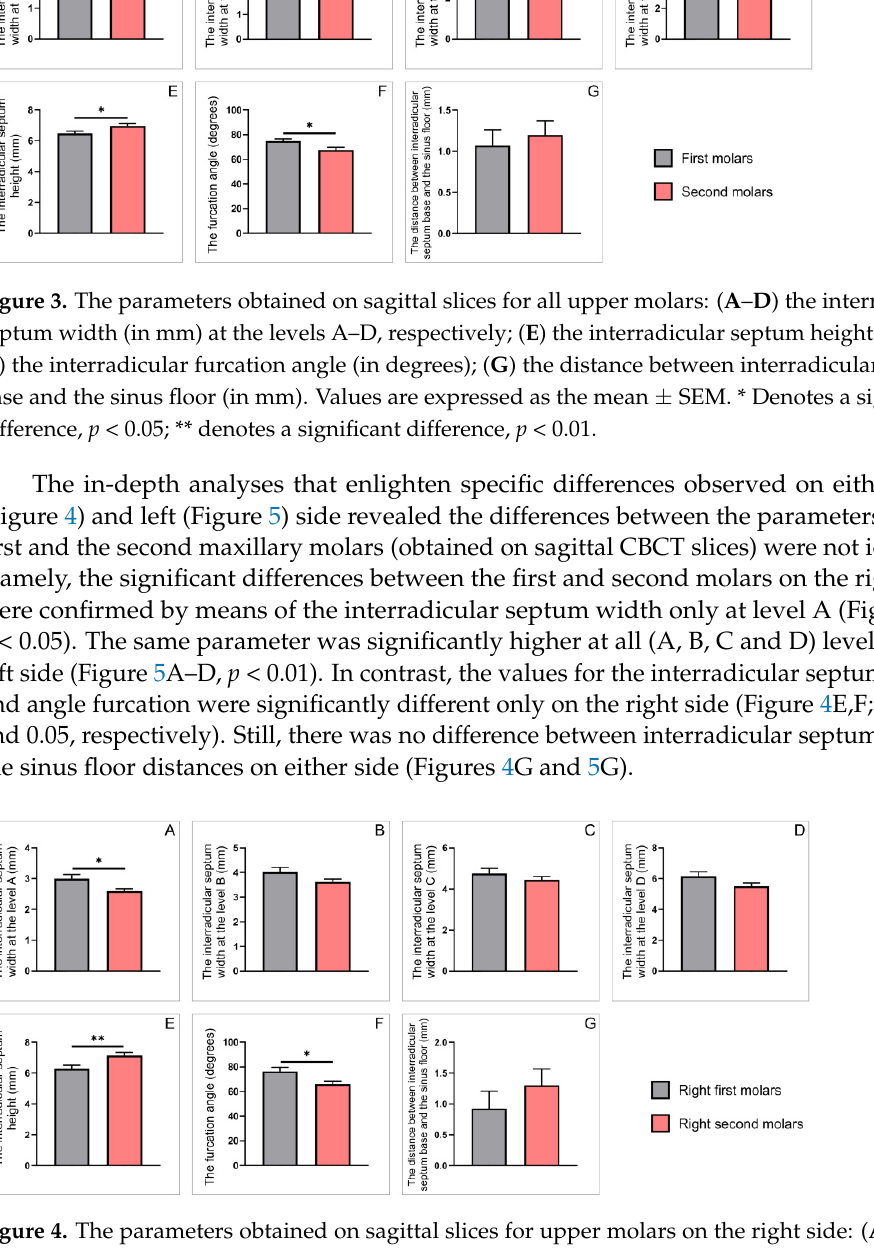
Figure 4. The parameters obtained on sagittal slices for upper molars on the right side: ( A – D ) the interradicular septum width (in mm) at the levels A–D, respectively; ( E ) the interradicular septum height (in mm); ( F ) the interradicular furcation angle (in degrees); ( G ) the distance between interradicular septum base and the sinus floor (in mm). Values are expressed as the mean ± SEM. * Denotes a significant difference, p < 0.05; ** denotes a significant difference, p < 0.01.